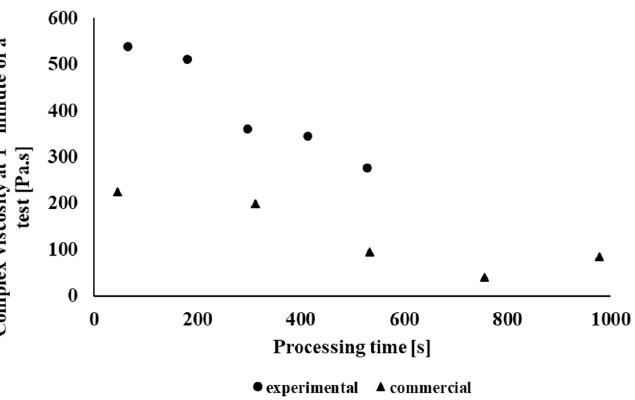
Figure 4. Dependence of the complex viscosity in the 1st minute of the test in an oscillating rheometer on the processing time of the NONOILEN ® 3D 3056-2 material.